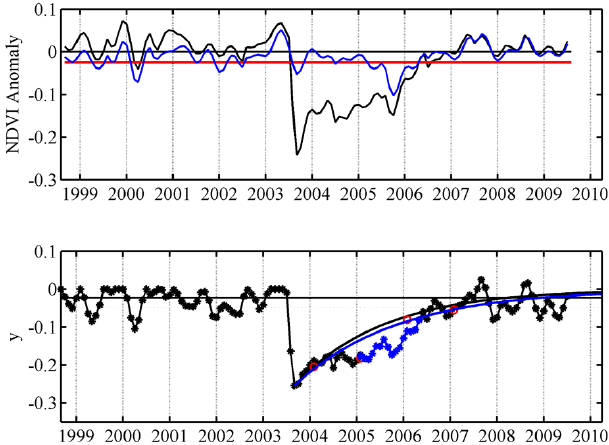
Fig. 7. Monthly NDVI anomaly time series (top) averaged over burn pixels in A3, (black line), and over the corresponding control area (blue line). The red line indicates the NDVI anomaly threshold of − 0.025. The horizontal solid line represents the mean value of y during the pre-fire period and the dashed line (bottom panel) the level of vegetation recovery defined as 90% of mean. Time series of y in bottom panel shows observed values using the original dataset (black line with asterisks) and values corresponding to the drought period (blue line with asterisks). Modelled recovery using the orig- inal dataset (black curve) and setting values corresponding to the drought period as no-value data (blue